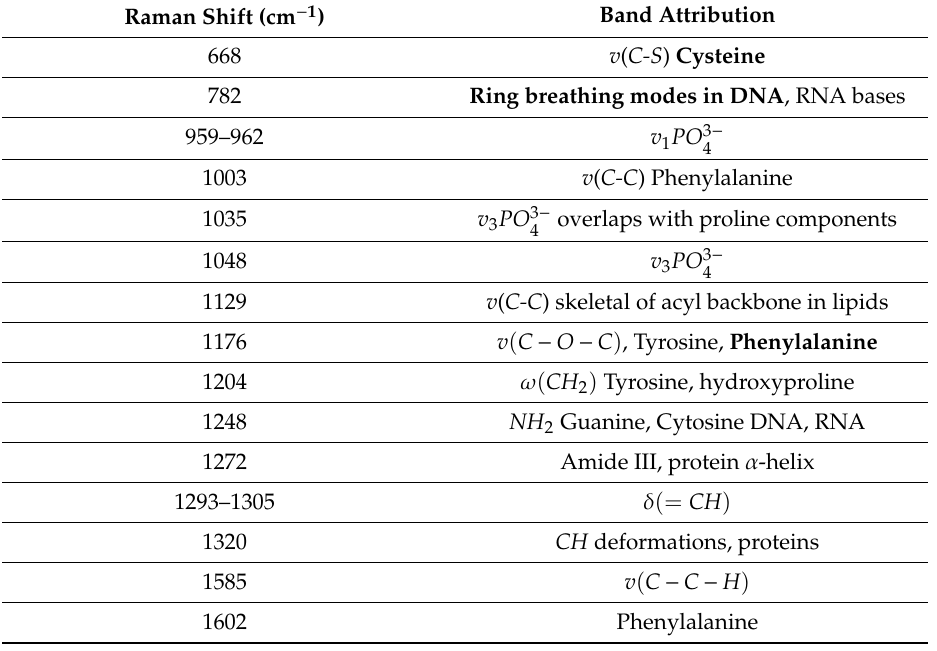
Table 1. Peak position and assignment of major Raman bands observed in MG-63 cells with respect osteo-di ff erentiated MSCs. In bold are the bands characterizing the MG-63 cells. References